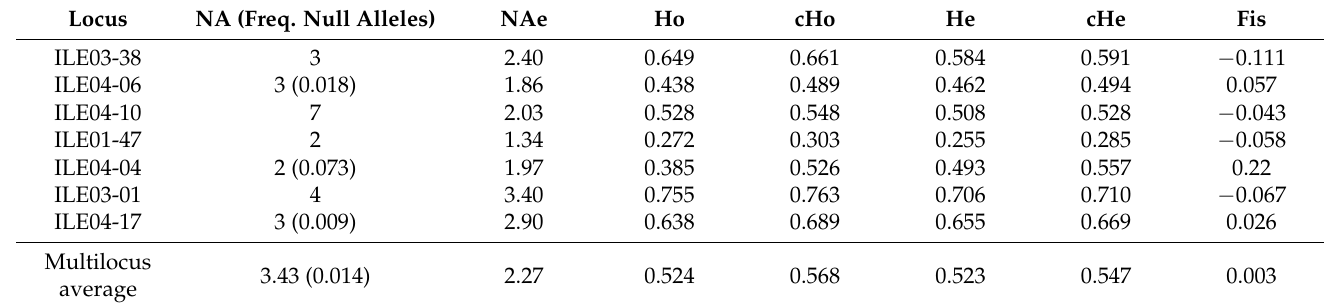
Table 1. Genetic diversity parameters (N = 141). NA: number of alleles and in brackets; if greater than zero, the Brookfield2 estimator for null allele frequency; NAe: effective number of alleles; Ho and He: observed and expected heterozygosity; cHo and cHe observed and expected heterozygosity corrected for null alleles in locus ILE04-04. Fis: inbreeding coefficient for each locus and